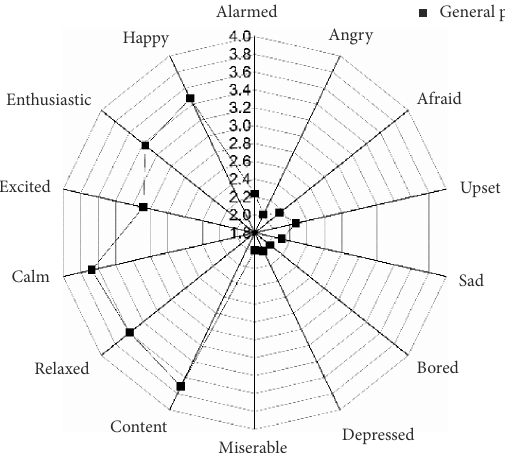
Figure 1. Average strength of 14 kinds of emotions for all participants (rated on a 5-point scale, with 5 representing very